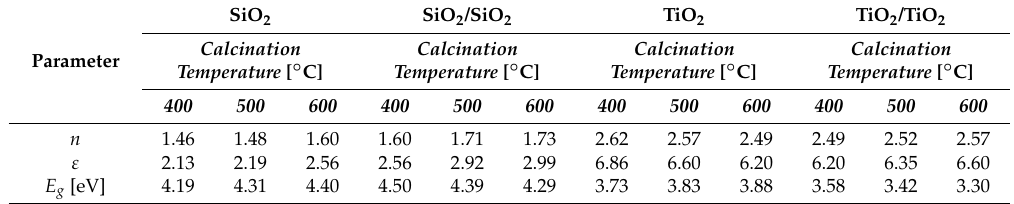
Table 1. Determined values of the complex refractive index, dielectric permittivity and energy gap width values obtained for the produced